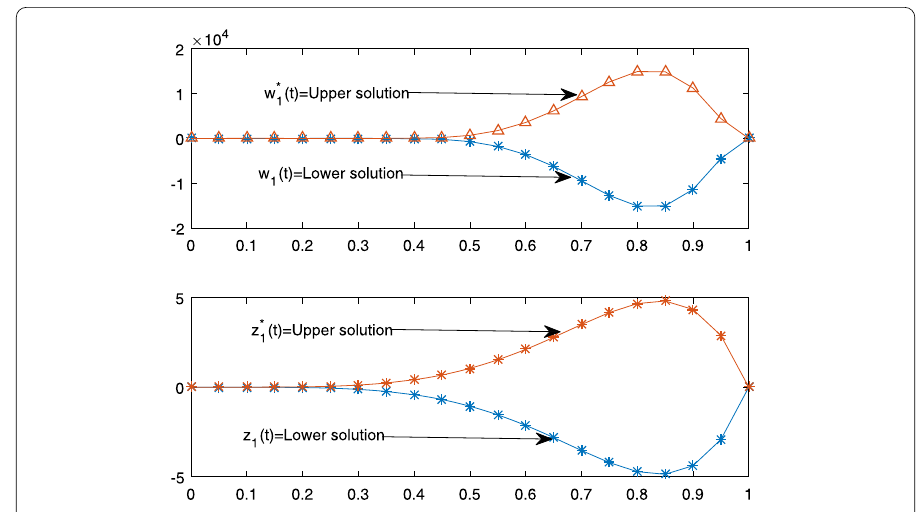
Figure 1 A line graph of the solutions of Example